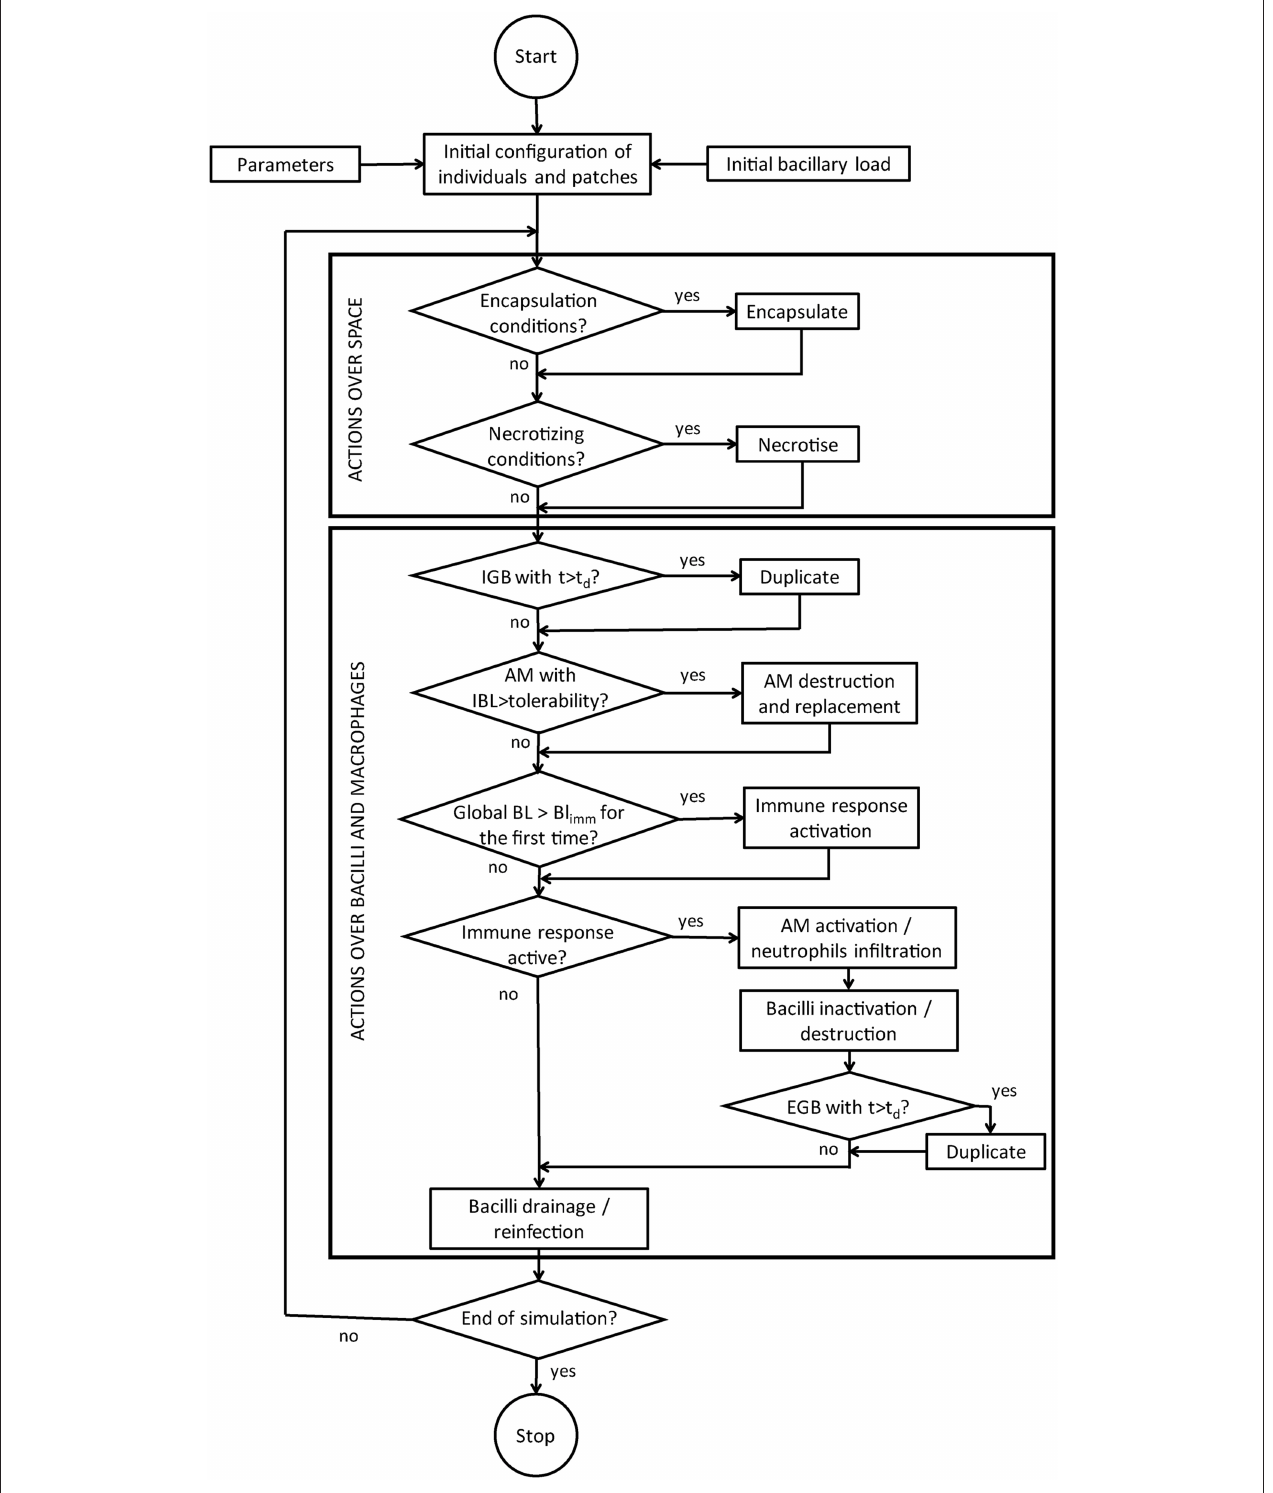
FIGURE 1 | Flow chart of the computer